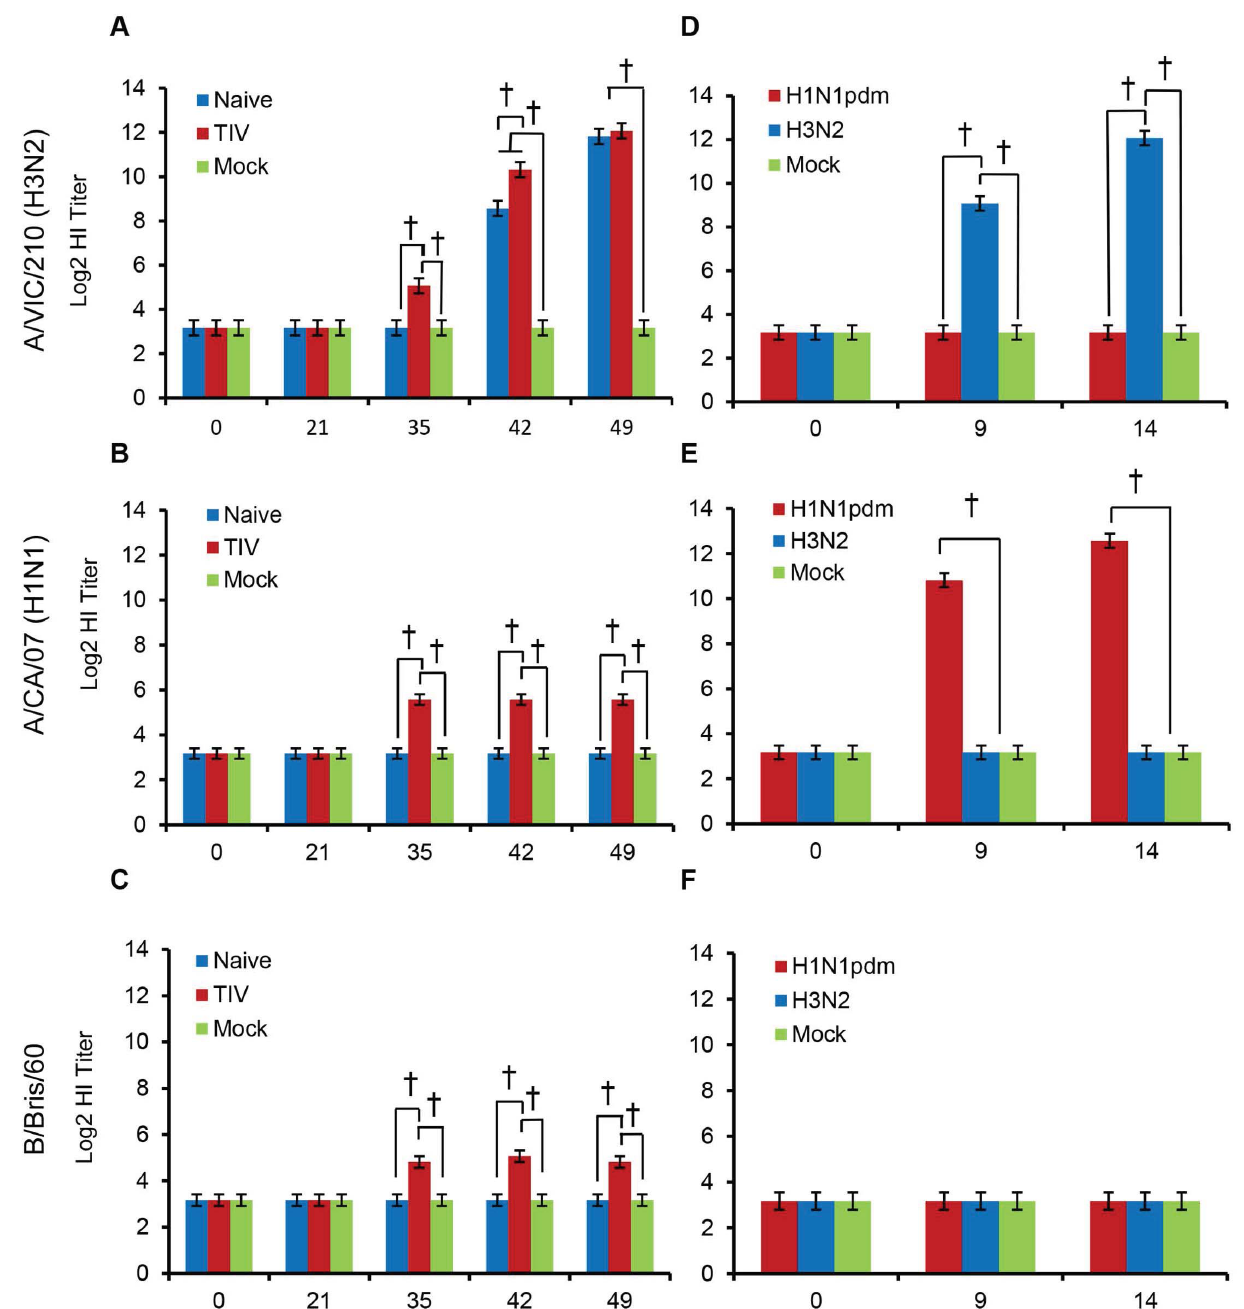
Figure 2. Hemagglutination inhibition (HI) titers. ( A–C ) Ferrets were immunized with commercial human TIV on days 0 and 21, and challenged with Perth/16 on day 35. Blood samples were collected on days 0, 21, 35, 42, and 49. ( D–F ) Ferrets were challenged with Perth/16 and NY/21 on day 0. Blood samples were collected on days 0, 9 and 14. HI assays were performed using ( A, D ) A/Victoria/210/2009 (H3N2), ( B, E ) A/California/07/2009 (H1N1pdm), and ( C, F ) B/Brisbane/60/2008 antigen controls. ‘‘Mock’’, unvaccinated mock-infected animals; ‘‘Naı¨ve’’, unvaccinated animals challenged with Perth/16; ‘‘TIV’’, vaccinated animals challenged with Perth/16; ‘‘H3N2’’, unvaccinated animals challenged with Perth/16; ‘‘H1N1pdm’’, unvaccinated animals challenged with NY/21. { indicates p , 0.0001; * indicates 0.0001 , p , 0.05. Error bars represent 95% confidence intervals, calculated using compound symmetry covariance to pool variability across groups. doi:10.1371/journal.pone.0100926.g002 changes were very consistent among animals, with each ferret variation between individuals on subsequent days, though clear showing very similar duration and extent of change in cellularity trends were readily detected (Figure S2). (Figure S2). Following these highly consistent changes in early In summary, although clinical signs were relatively mild and infection, lymphocyte and granulocyte numbers showed more transient, changes in leukocyte subsets were rapid and dramatic. Transient lymphopenia affected both CD8 + and CD3 + /CD8 2 T